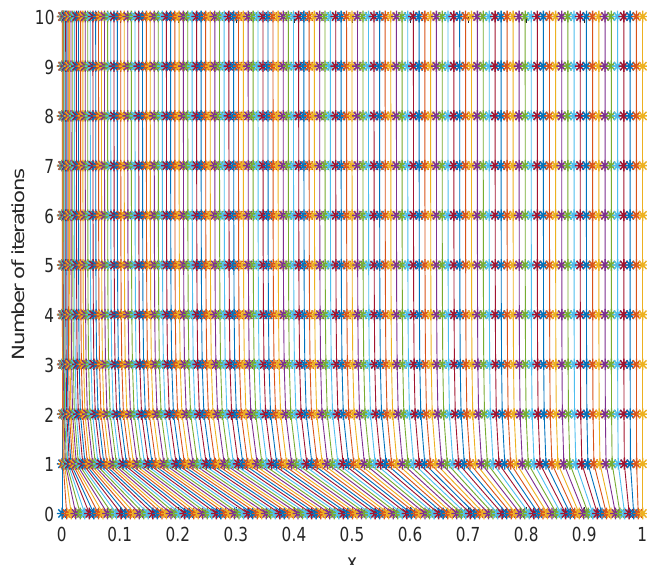
Figure 1. Numerical solutions with N = 64 and different values of α .